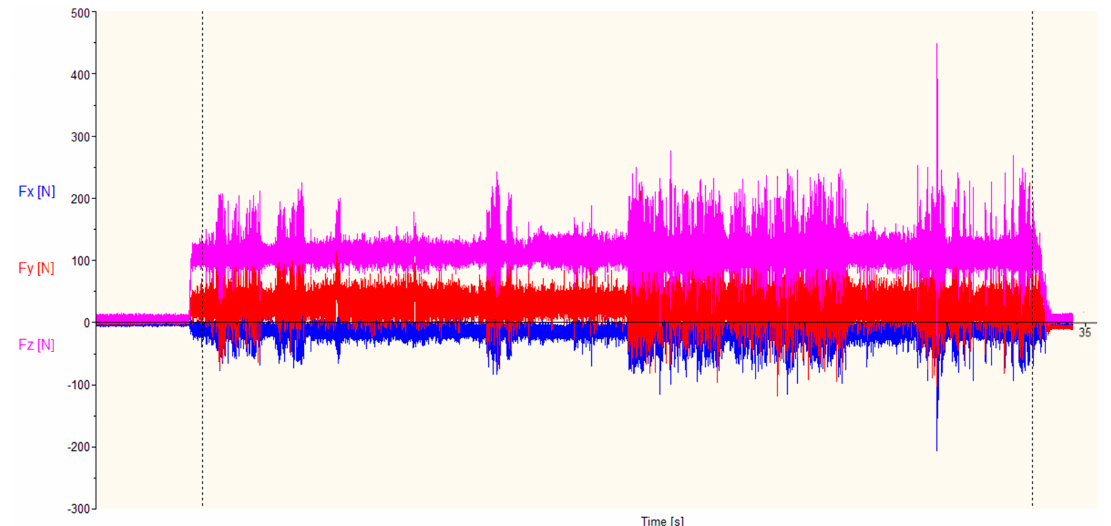
Figure 13. Cutting forces during turning with parameters: ap = 2.0 mm, f = 0.10 mm / rev.